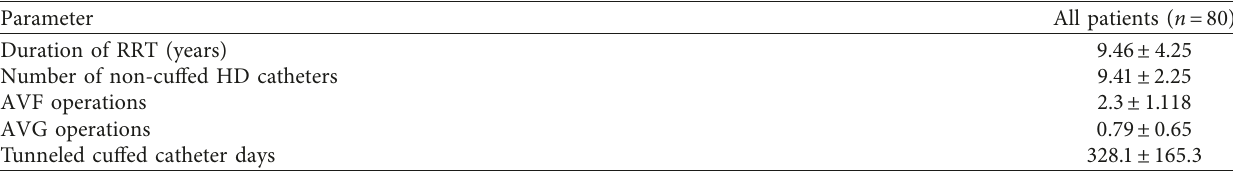
Table 2: Renal replacement therapy duration and vascular access history.